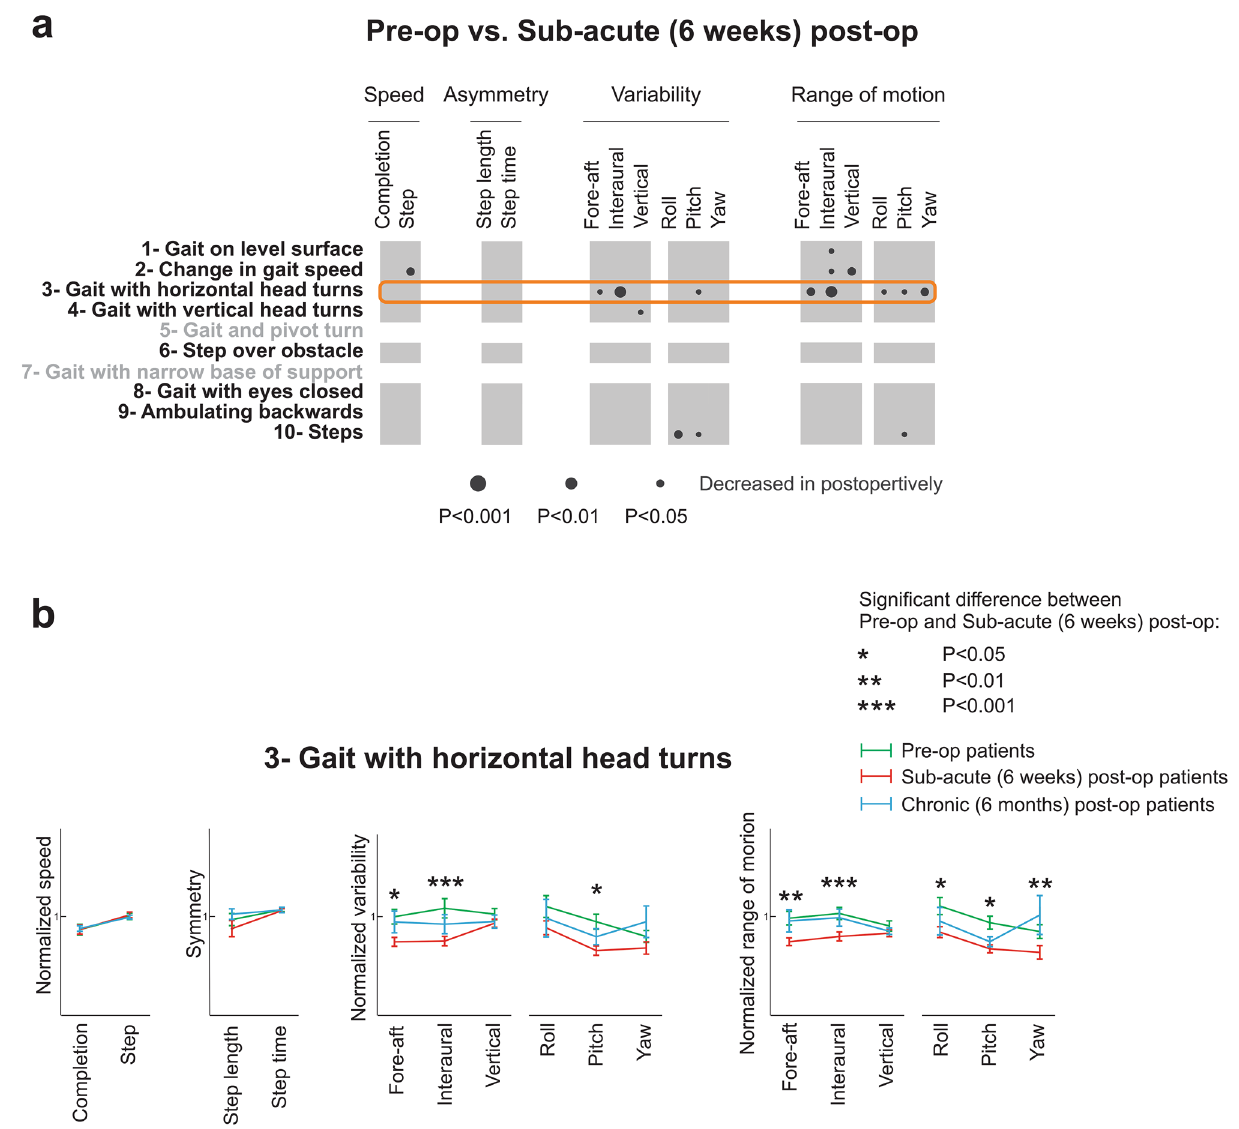
Figure 4. Comparison of objective head movement kinematics of patients 6 weeks following the surgery with their pre-op state. ( a ) Each column corresponds to a kinematic measure, while rows indicated FGA tasks. Dark circles show decreased measure 6 weeks after the surgery. The radius of the circle indicates the level of significance of the difference between the two groups. Orange box indicates the FGA task in which patients altered their kinematics the most from pre-op and sub-acute patients ( b ) The normalized value of all kinematic measures for patients across all time points during more informative tasks of the FGA: ‘gait with horizontal head turns’ (task 3). Green, red, and blue lines correspond to pre-op, sub-acute post-op, and chronic post-op patients. Asterisks denote the kinematic measures that were significantly different between pre-op and sub-acute post-op